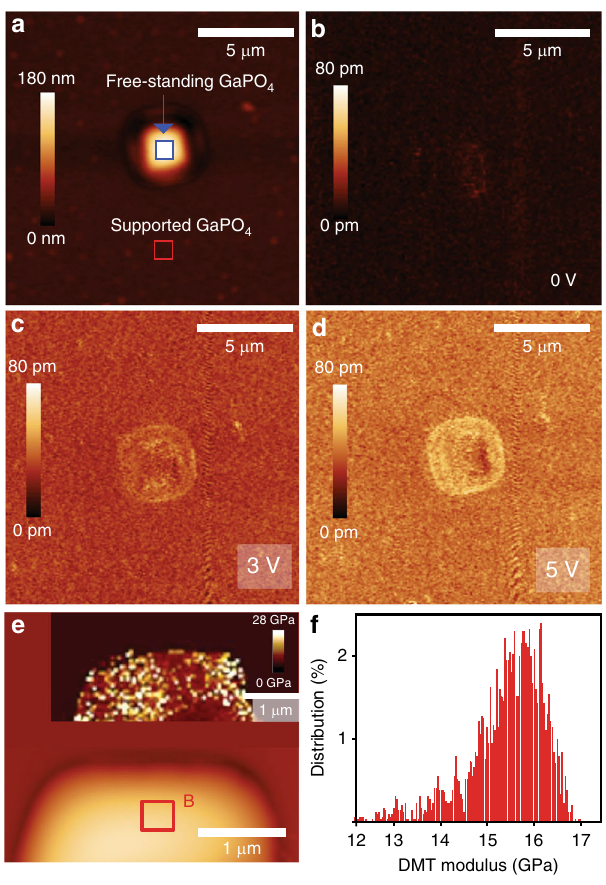
Fig. 5 Piezoelectric and elastic properties of free-standing GaPO 4 nanosheet. a AFM topography and b – d vertical piezoresponse of free- standing GaPO 4 nanosheet at different AC drive excitation. e AFM image of a free-standing GaPO 4 fl ake with DMT modulus map (inset). f DMT modulus distributions measured for the fl at section (area B of e ) of the GaPO 4 sheet. The Gaussian mean value of the modulus is found around 15.66 ± 0.0095